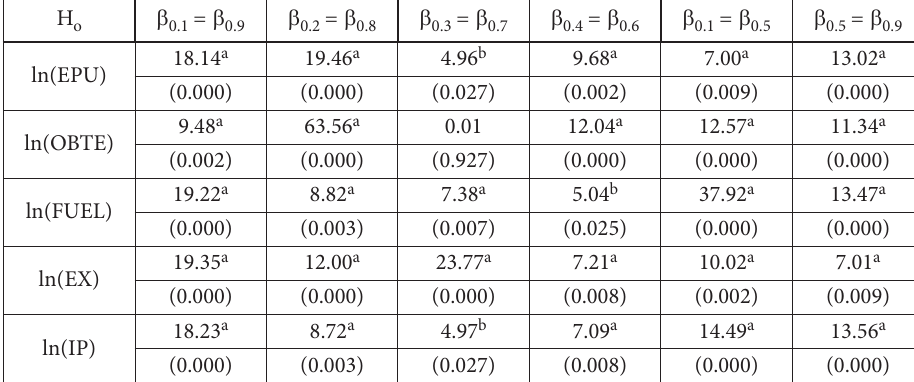
Table 3. Model 1: Results of the symmetric quantile test H o